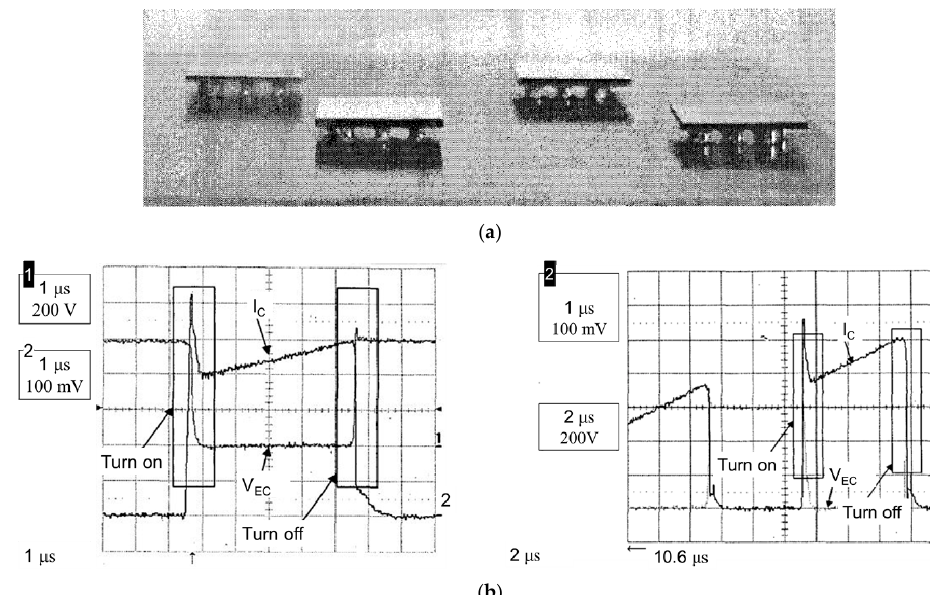
Figure 10. Flip-chip integrated power module showing: ( a ) a photograph of the flip-chipped devices; and ( b ) the switching waveforms for a module using commercially packaged wire bonded devices ( left ) and the flip-chip on flex (FCOF) module ( right ) [54]. Reprint with permission [4062750066013]; Copyright 2001, IEEE.